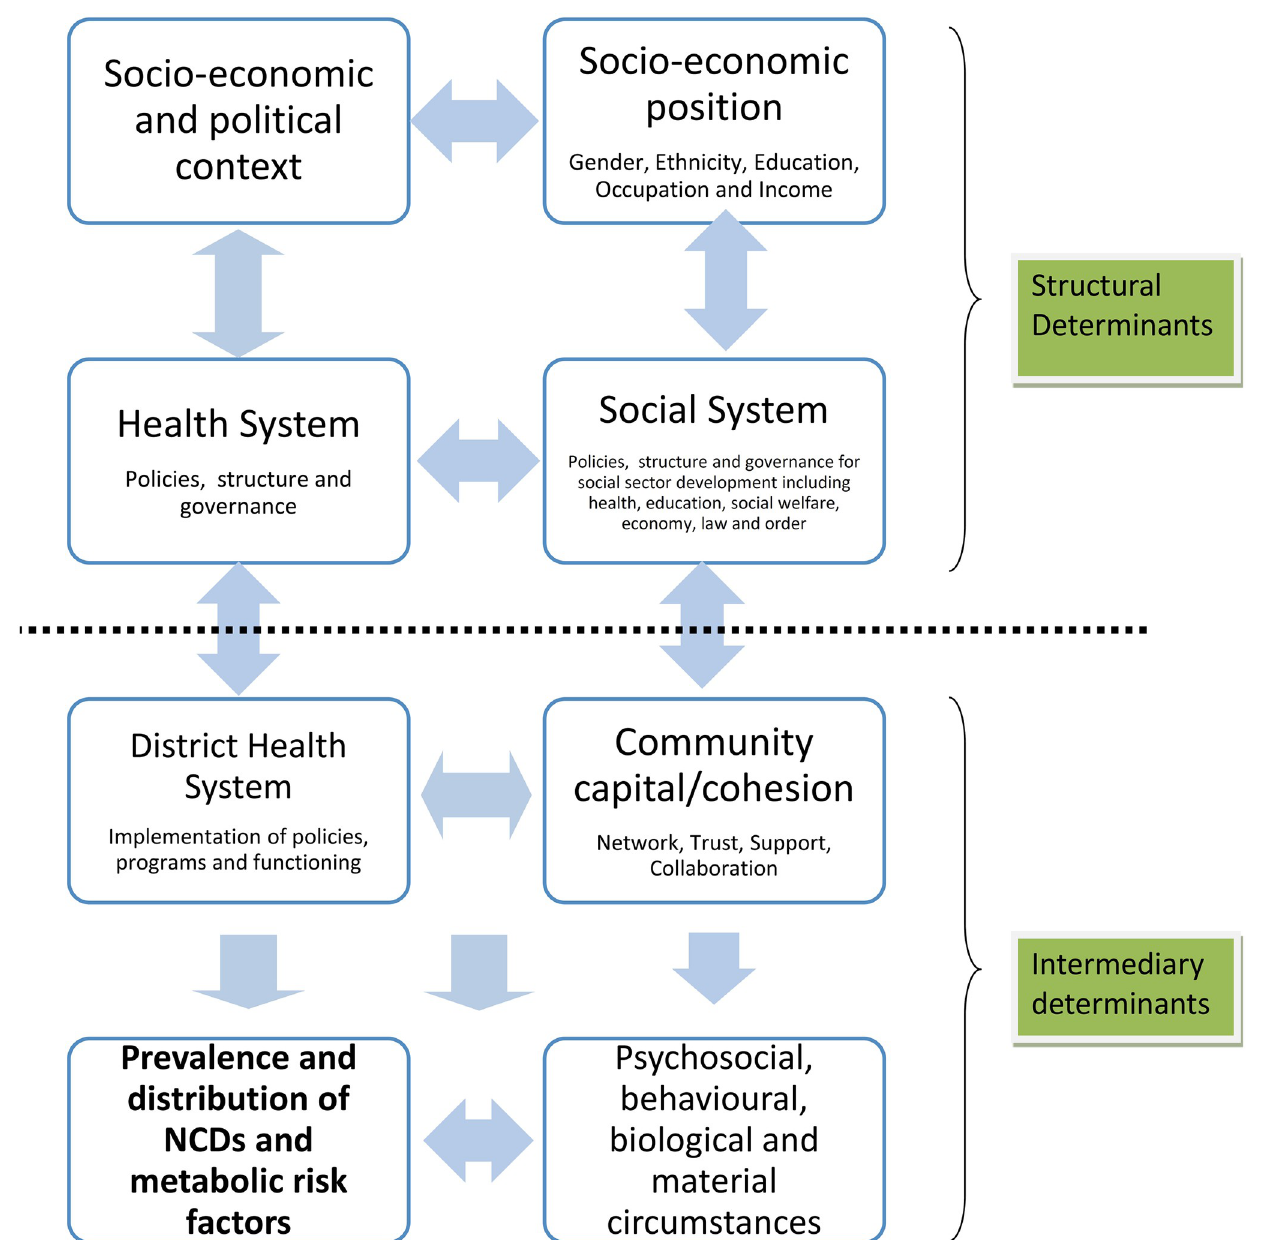
Fig 2. Adapted Social determinants of health framework for the study of the social determinants of NCDs in Nepal (image republished from authors’ open access article [27]).